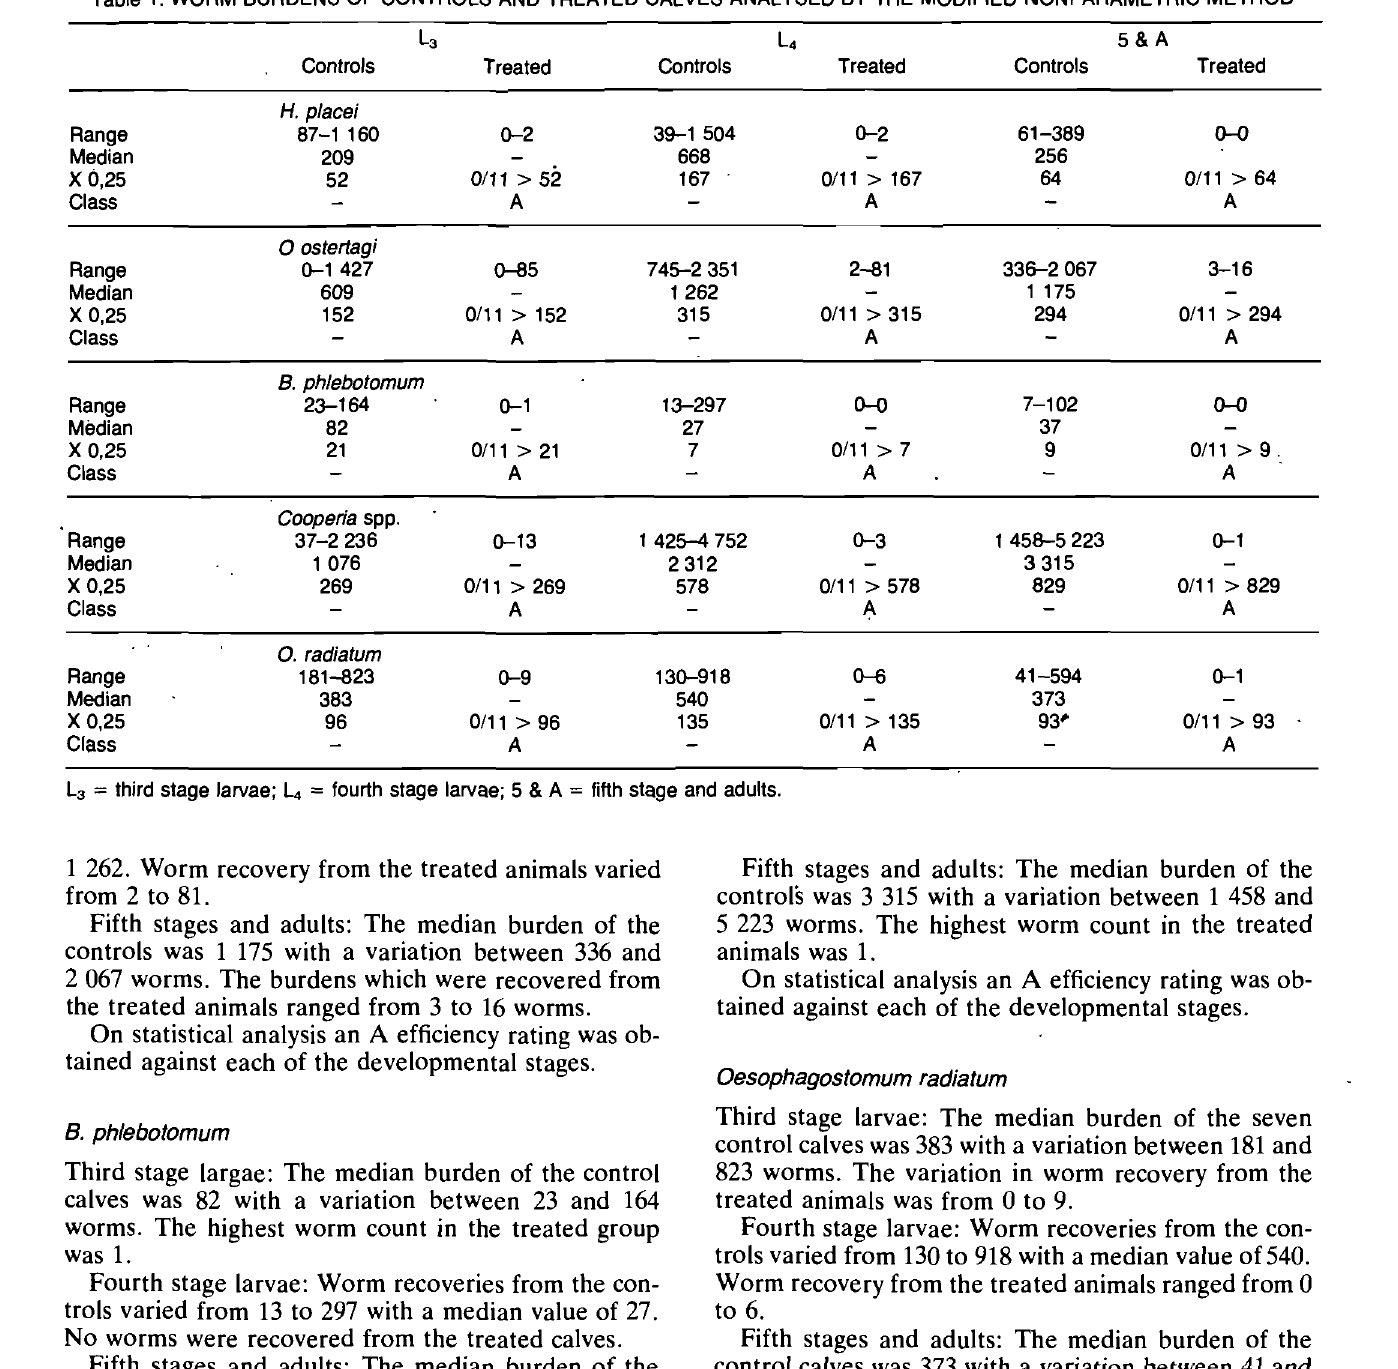
table 1: WORM BURDENS OF CONTROLS AND TREATED CALVES ANALYSED BY THE MODIFIED NON PARAMETRIC METHOO 3